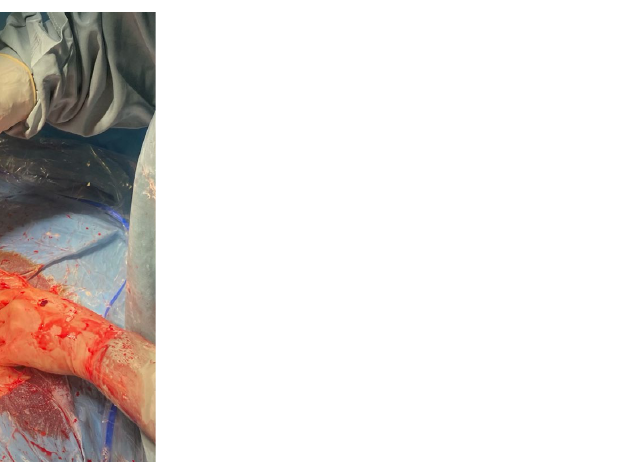
Figure 2. The assistant ensures that the uterine appendages are released on both sides by moving the uterus to the right and left.